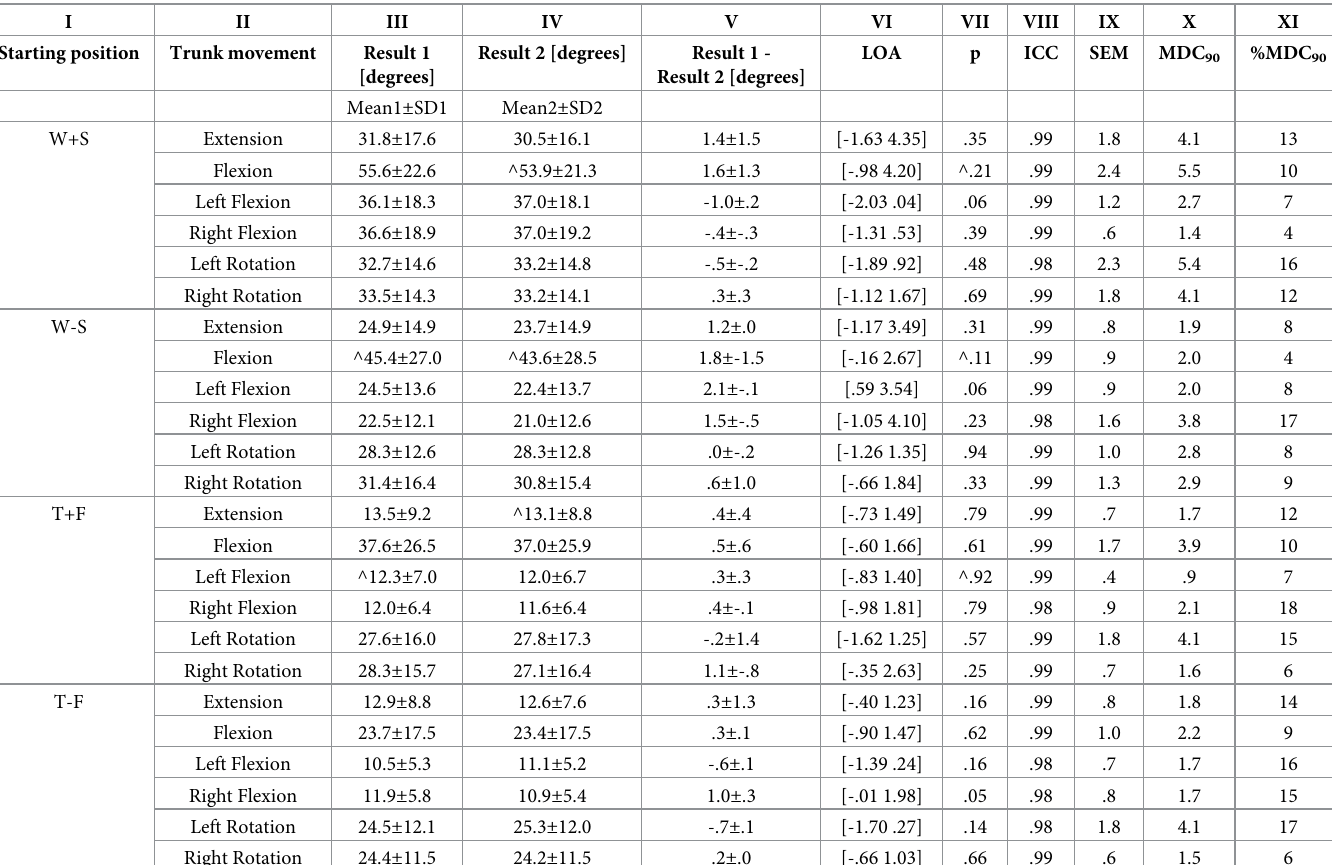
Table 1. Mean, standard deviation, and reliability results for trunk movements in the three planes and four sitting positions (n = 18).